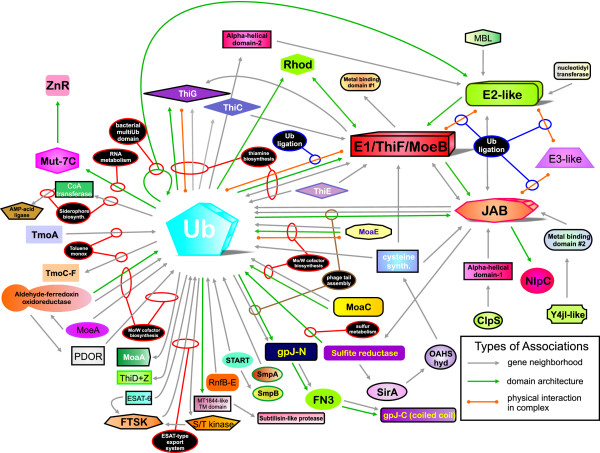
Network diagram of ThiS/MoaD-like β-grasp domains. The interaction network depicted here represents the known functional associations (arrows colored orange), the associations suggested by domain architectures (arrows colored green), and the associations suggested by gene neighborhood (arrows colored gray) between pairs of domains, as described in the text. The directionality of the network interactions, as indicated by an arrowhead, represents the order of a domain pair from the amino- to the carboxyl-terminus of the domain architecture or from the 5' to 3' end of a gene neighborhood. Lines with arrowheads at both ends represent domain pairs found both amino-terminal and carboxyl-terminal to each other in domain architectures or 5' to 3' in operonic contexts. The primary 'hubs' of the network are highlighted prominently. Domains are not exactly to scale. Selected interactions are encircled by small ellipses connected to the labels describing the functional role of the interaction. The labels are portrayed as large black ellipses with white lettering. MBL, metallo-β-lactamase domain; OAHS hyd, O-acetylhomoserine sulfhydrylase; PDOR, pyridine disulfide oxidoreductase; Rhod, Rhodanese-like domain; Toluene mono, toluene mono-oxygenase; ZnR, zinc-ribbon containing domain.